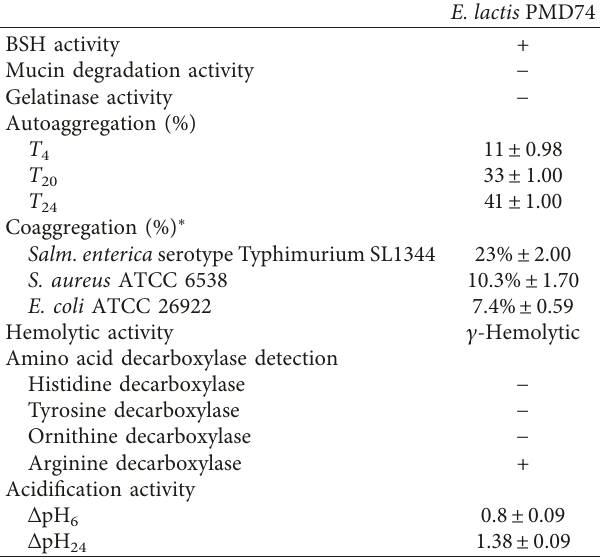
Table 5: Probiotic and technological properties of E. lactis